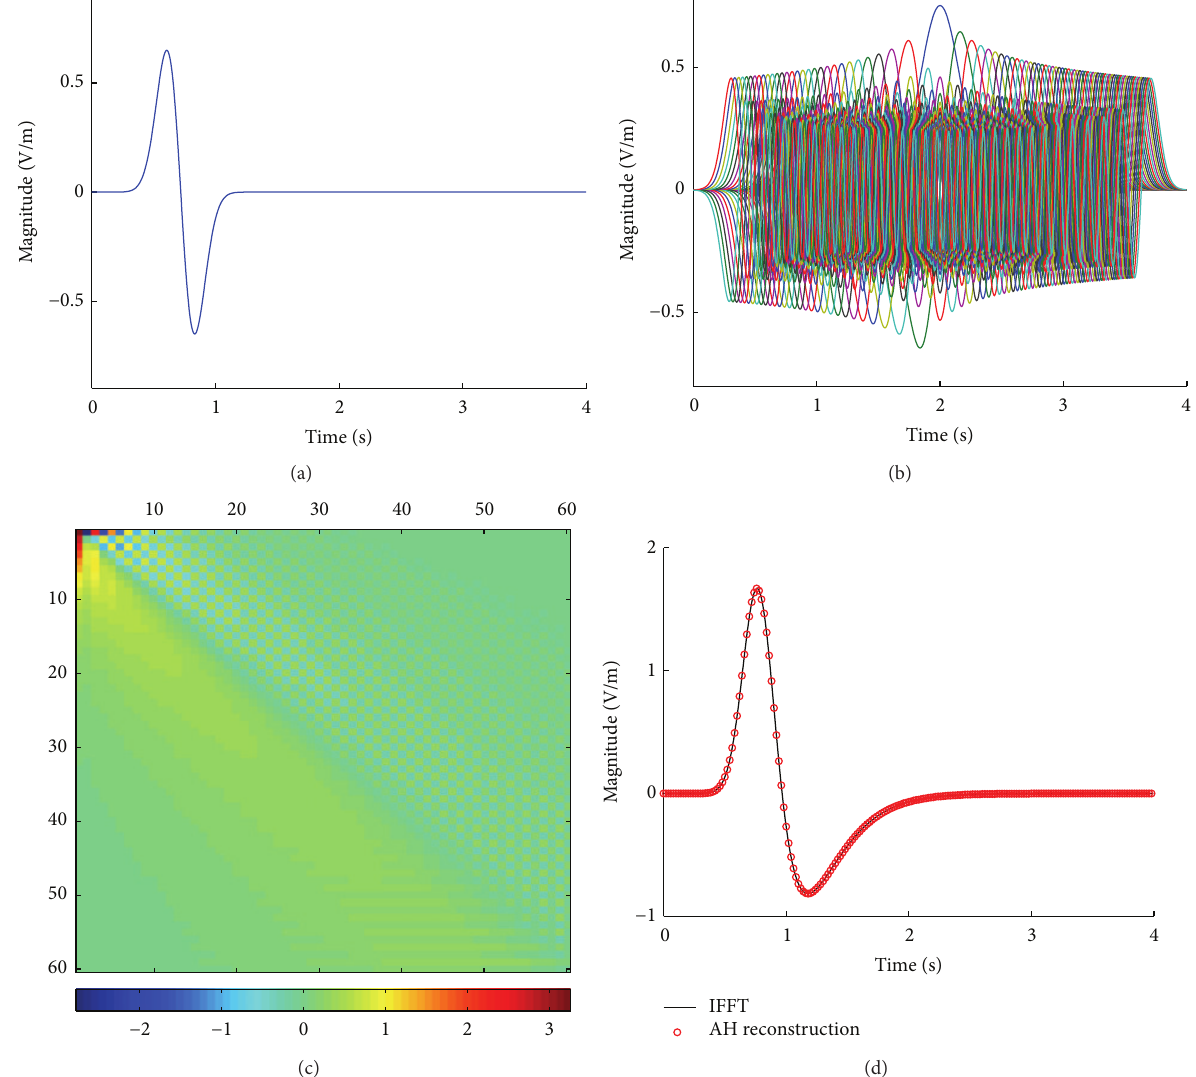
𝐻(𝜔) . (d) The output signals 𝑦 calculated by AH